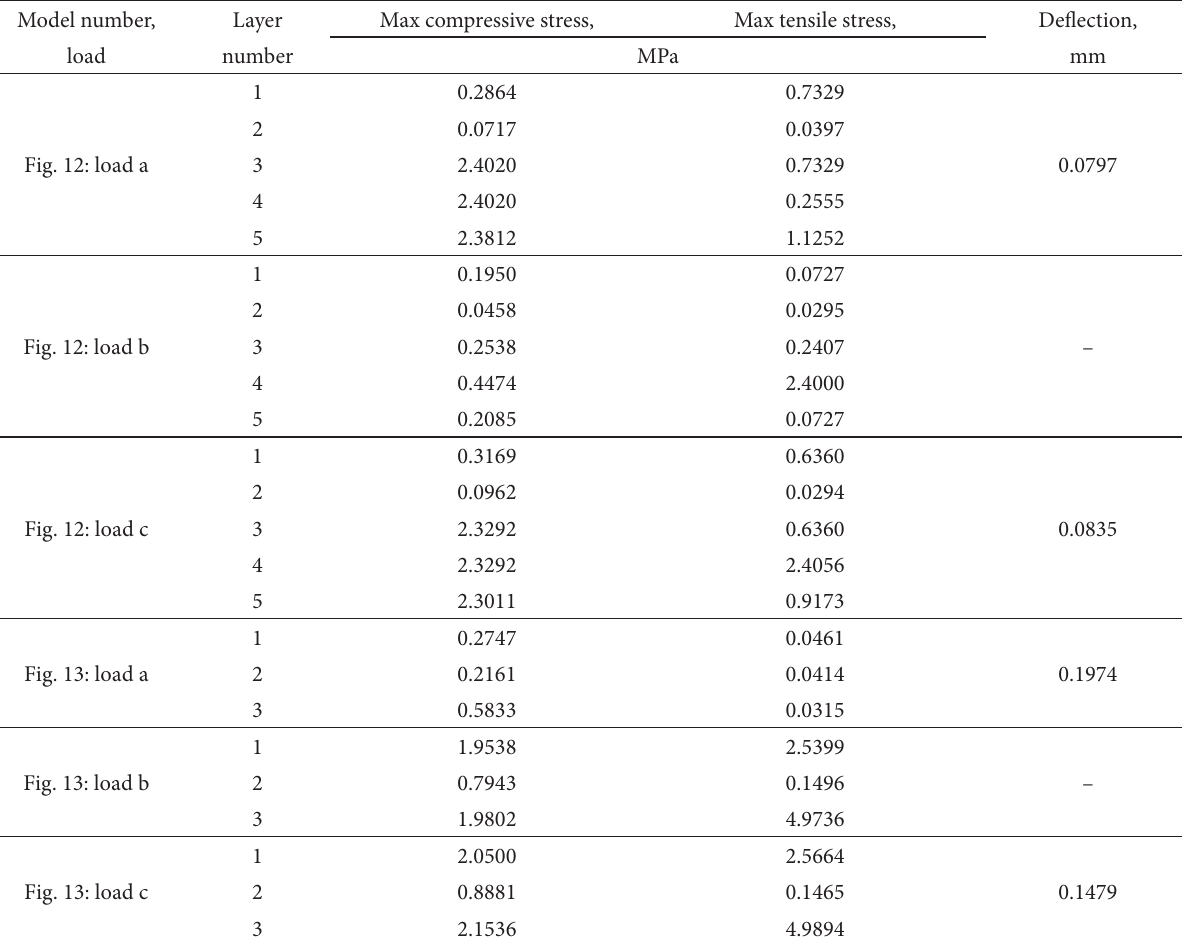
Table 6. Results of the mode of deformation research for schemes in Figs 12 and 13 Model number,